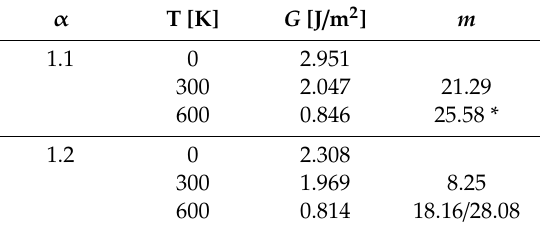
Table 4. Energy release rate G and degree of thermal activation m from MD at the crack initiation facilitated with twinning. The critical Gri ffi th level G crit = 2 γ s for the used potential is 2 γ 110 = 3.17 J / m 2 . The value marked by the asterisk * was excluded from the evaluation (see the text